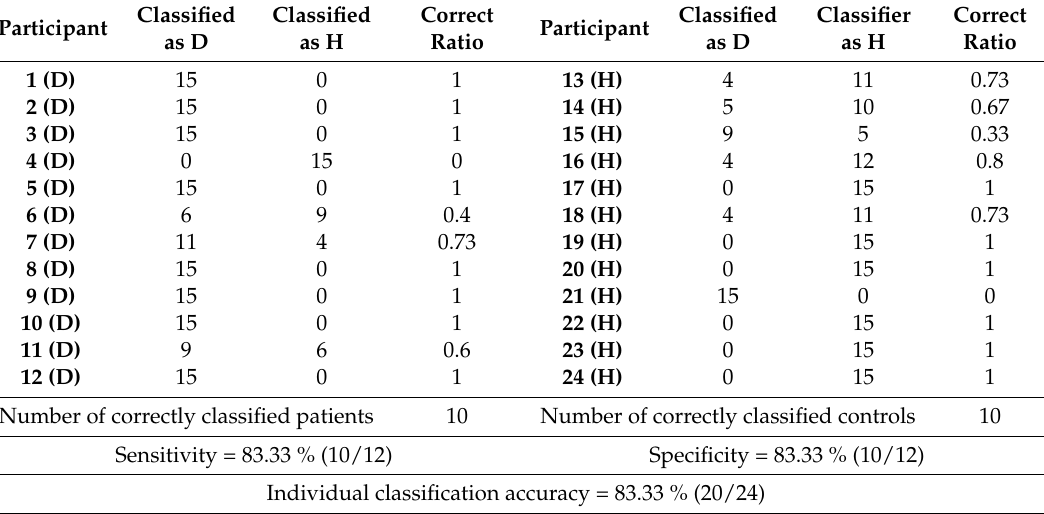
Table 6. The voting-based LOPO-CV results using the EEG signals of the first 15 trials ( n t = 15), KEFB-CSP feature, and SVM classifier.